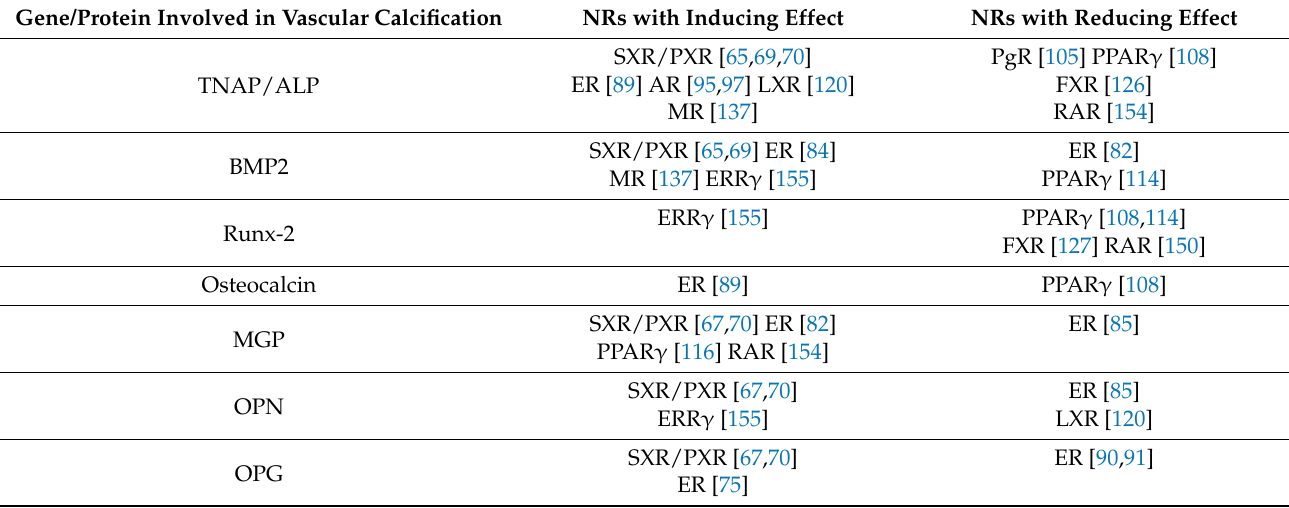
Table 2. List of genes/proteins involved in vascular calcification and how they are regulated by NRs. Gene/Protein Involved in Vascular